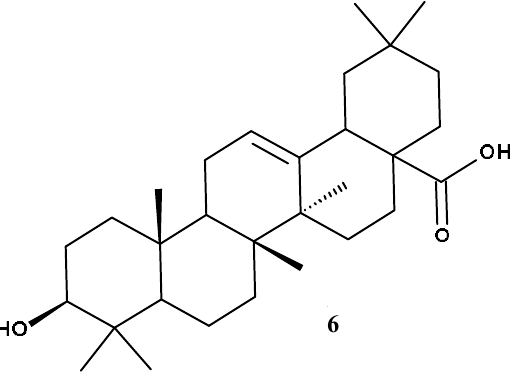
Figure 8. The chemical structure of oleanolic acid ( 6 ).